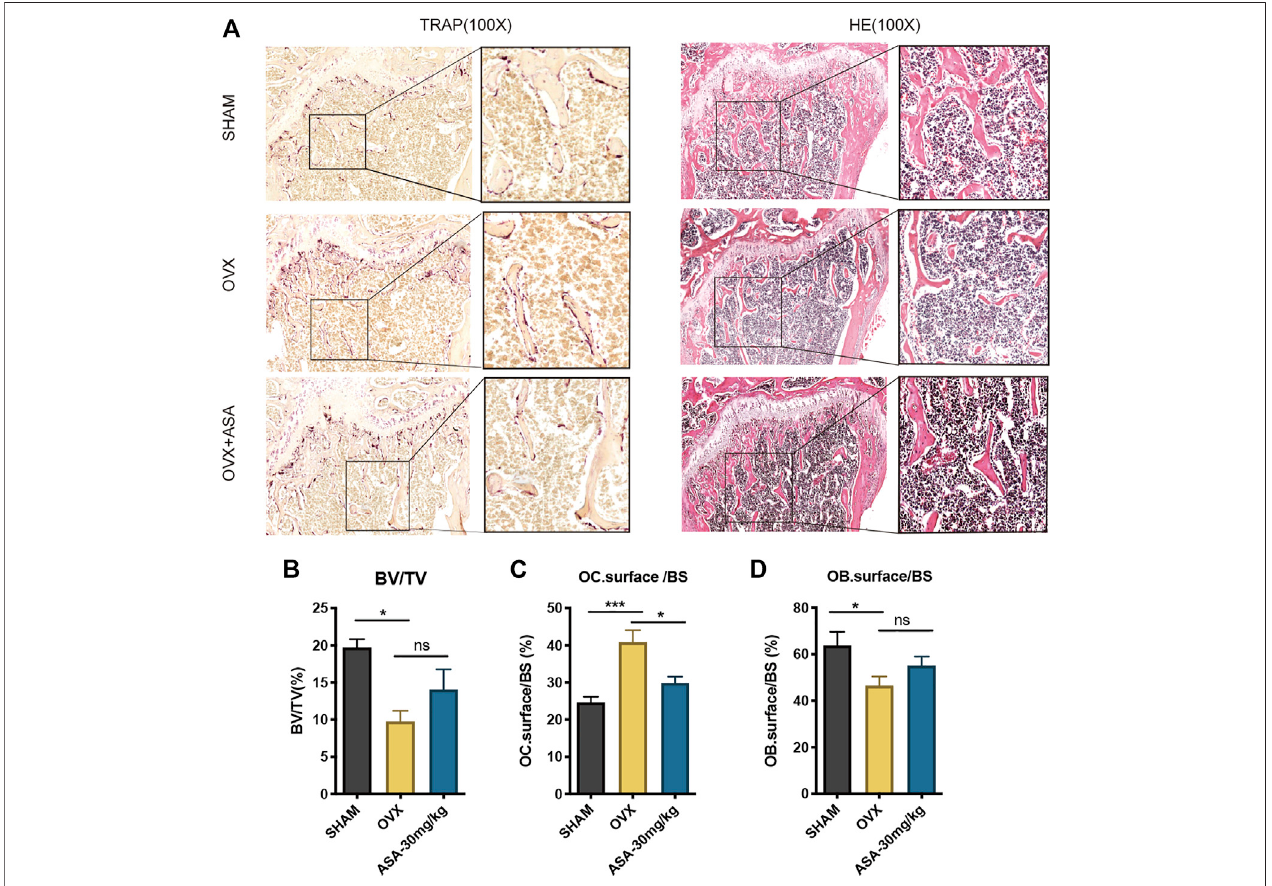
FIGURE 5 | Effects of ASA OBs and OCs in vivo . (A) Mouse femurs were fi xed, decalci fi ed, dehydrated and sectioned. TRAP staining and H&E staining were applied to show OCs in different groups of SHAM, OVX and OVX + ASA (30 mg/kg). Regions that stained red are considered as TRAP-positive OCs. (B) The bone volume per fi eld of bone tissue (BV/TV), the surface of OCs per bone surface (OC.surface/BS) and the surface of OBs per bone surface (OB.surface/BS) were analyzed.